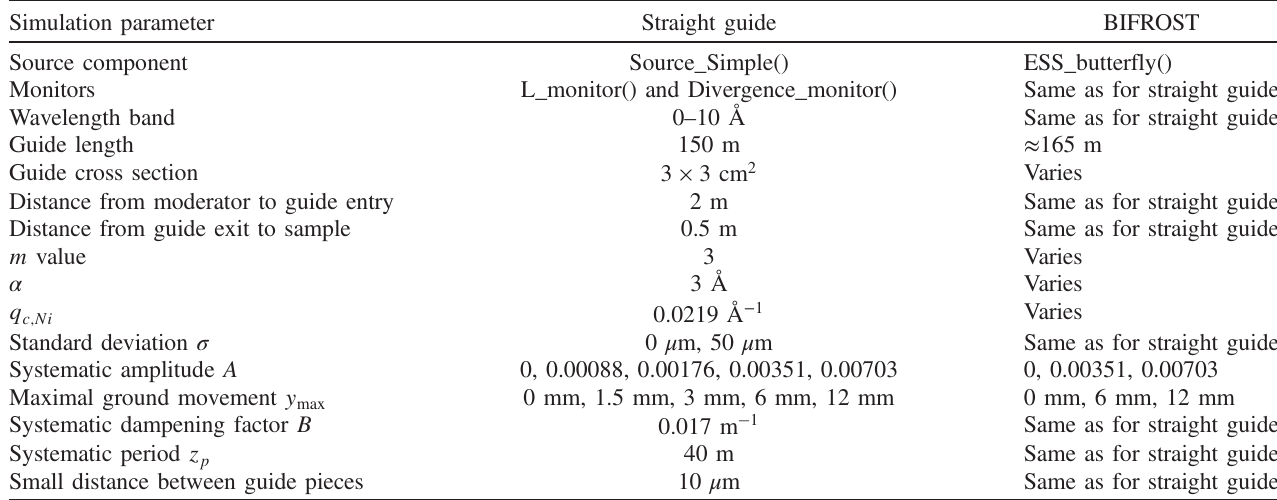
TABLE I. Simulation specifications for models 1, 2 and 3 on the straight guide, and for model 3 on the BIFROST guide. For a more detailed overview of the geometry of the BIFROST guide see Fig. 8.